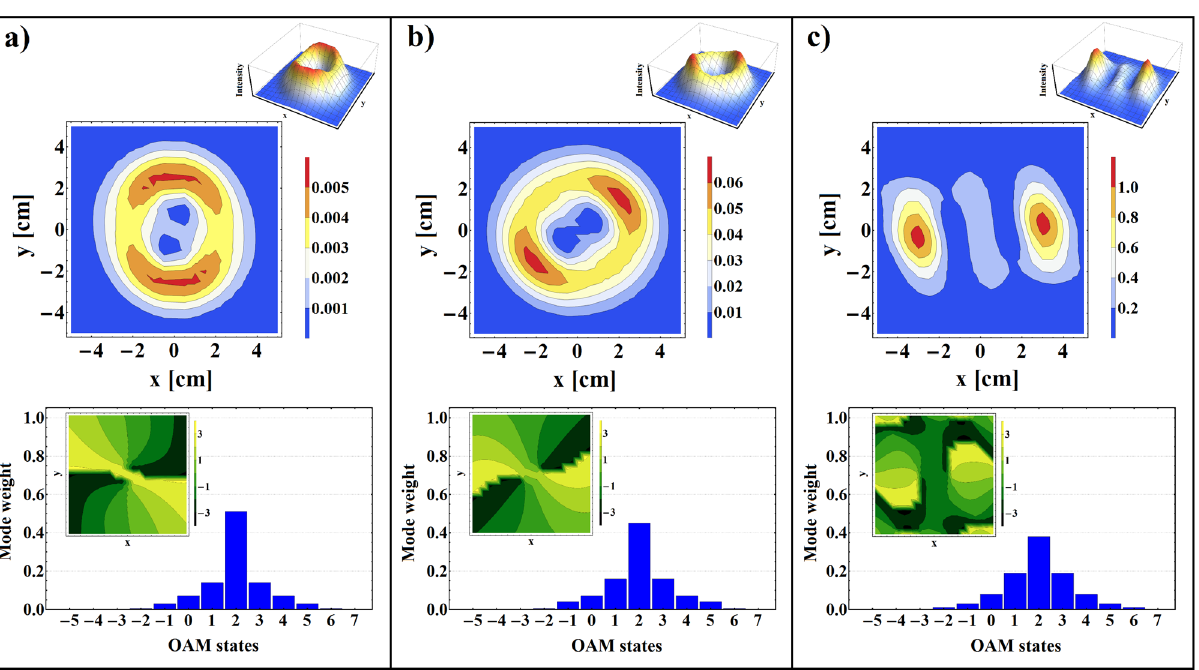
Figure 6. Intensity profiles accompanied by corresponding phase maps and OAM spectrums of transmitted VB 4000 Oe , ℓ for H 0 = n e 4.5 10 12 cm = ×